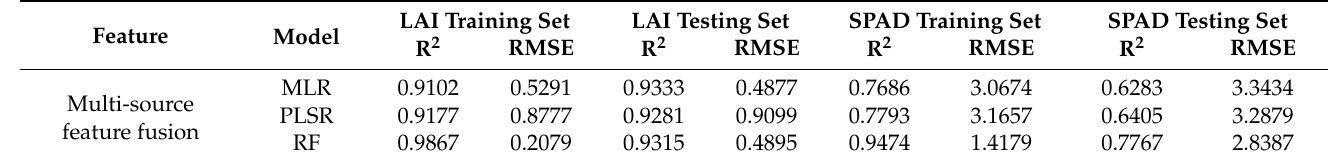
Table 6. LAI and SPAD inversion models under multi-source